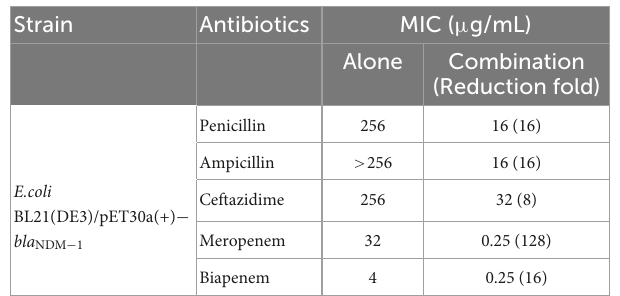
TABLE 1 MIC ( µ g/mL) of antibiotics against E.coli BL21(DE3)/pET30a(+) - bla NDM − 1 . Strain Antibiotics MIC ( µ g/mL)